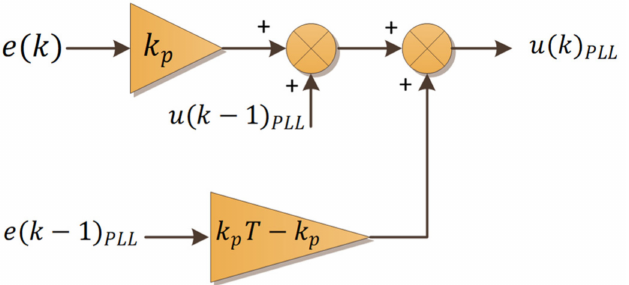
Figure 14. Block diagram for the implementation of the PI controller.